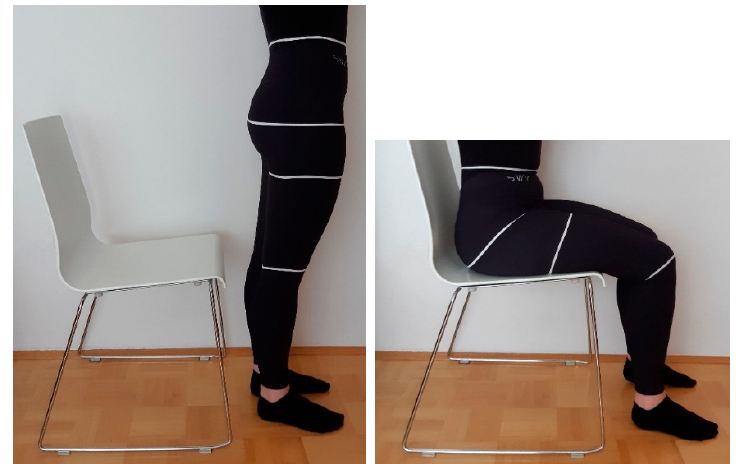
Figure 1. Measurement of real body dimensions.